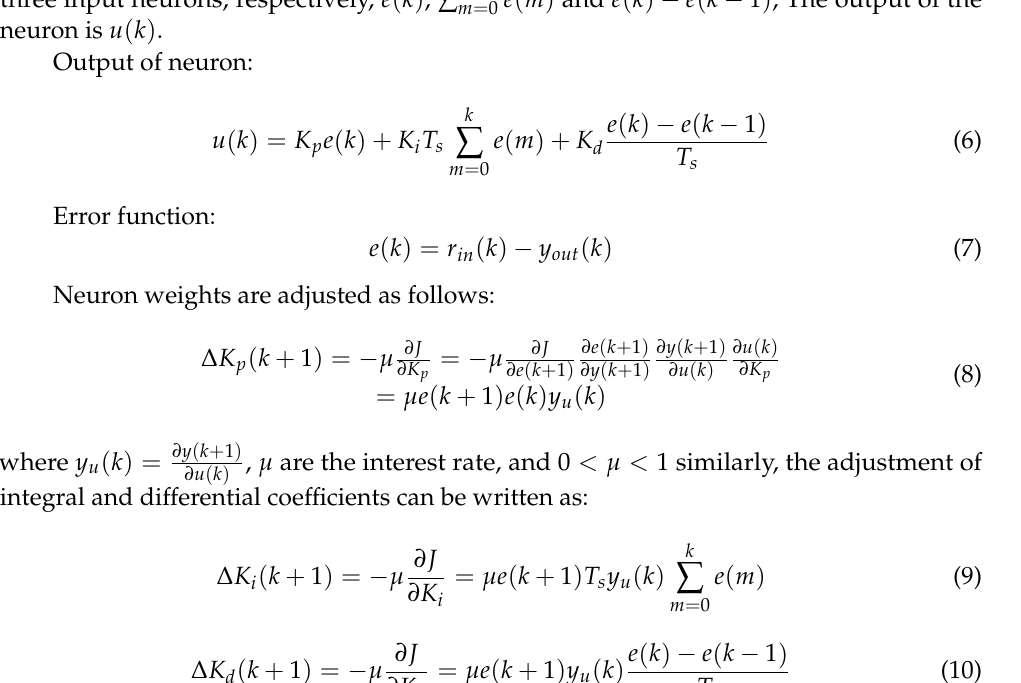
Figure 8. Curves of identification results of magnetorheological suspension inverse model. Table 2. Relative approximation accuracy of magnetorheological suspension inverse mode.